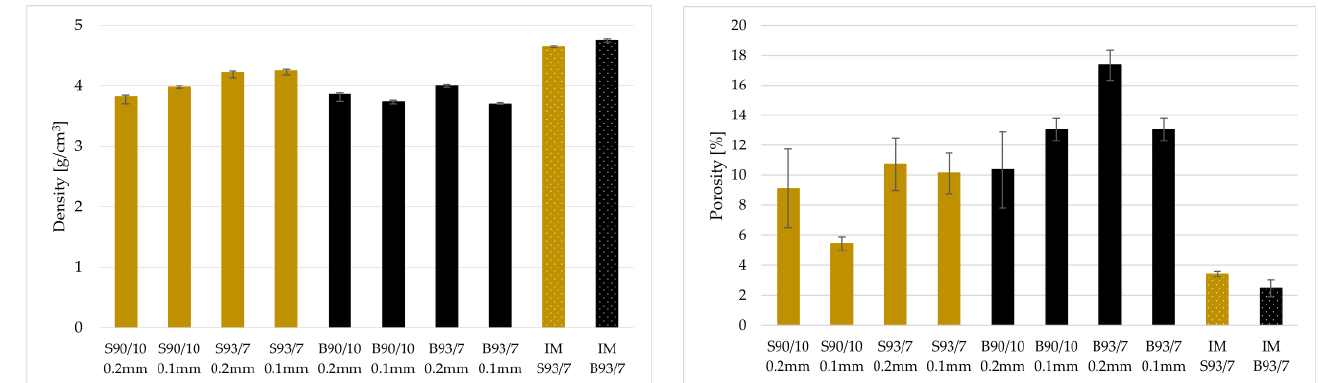
Figure 7 . Bar charts of density and calculated porosity of FDM-printed magnets, with various filler loadings and printing heights, and injection-moulded magnets.